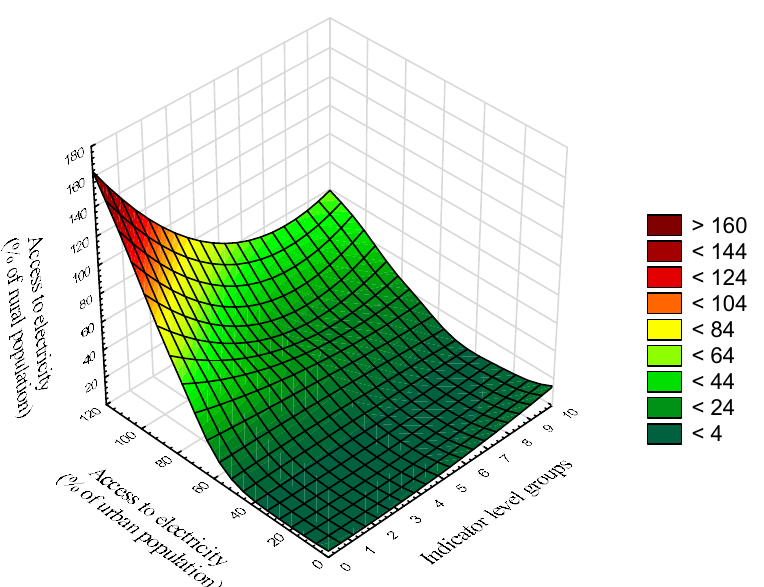
Figure 6. Distribution of the values of indicators for access to electricity (% of population) and access to electricity (% of rural population) in relation to the classification by levels of all indicators from 2000 to 2019. Source: own